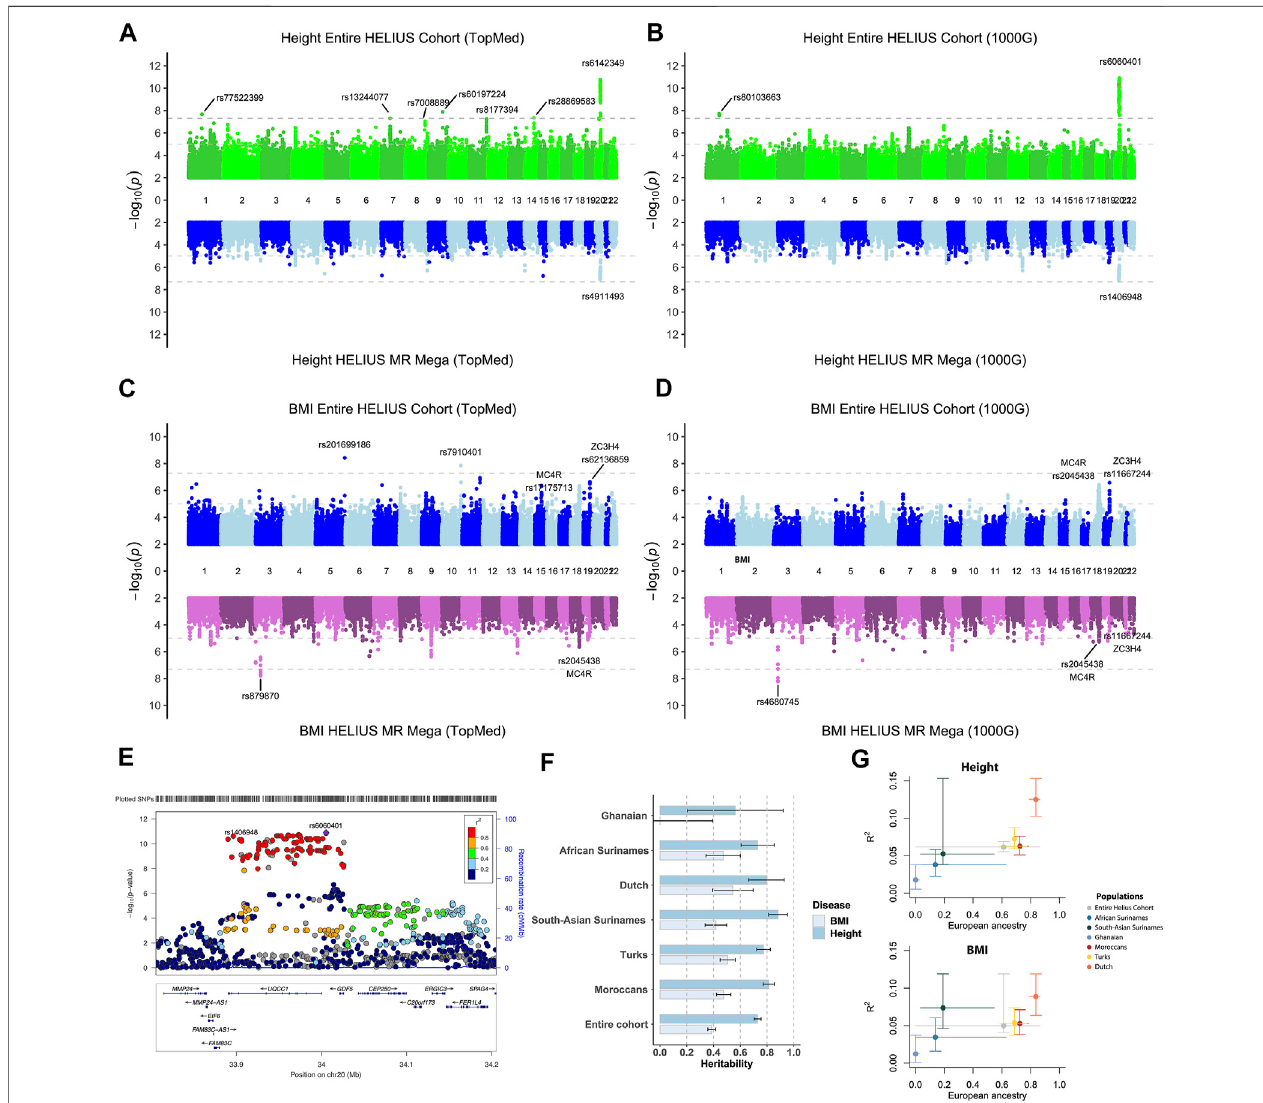
FIGURE 3 | Height and BMI association study on the HELIUS cohort. Miami plot of the height and BMI using the TopMed (A, C) or Sanger 1000G imputation referencecohort (B,D) GWAS.Resultsoftheentirecohortareplottedatthetoppanels,andtheMR-MEGAmeta-analysiscombinestheethnic-speci fi cGWASresultsat the bottom panel. Y -axis displays the -log10 p values and the x -axis the associated marker location on each chromosome. Gray dashed lines indicate the 1.0e-5 and genome-widesigni fi cant5.0e-8 p -valuethresholds. (E) Locuszoomoftheheightassociationpeakonchromosome20showingtheassociatedlociUQCC1/GDF5 within the area. (F) Heritability, and standard error, bar plot for the entire or ethnic-speci fi c cohort, and each ethnic-speci fi c GWAS for the BMI and height. The PRS for BMIandheightisdisplayedin (G) .The y -axisrepresentsthe “ best fi tted ” R2fortheentirecohortandeachethnicitywithverticalerrorbarsrepresentingthebootstrapping con fi denceinterval.TheaverageproportionofEuropean ancestry,basedontheADMIXTUREK (cid:1) 3calculations,fortheentirecohortandperethnicityisdisplayedatthe x -axis. Horizontal lines were drawn between the smallest and largest measured European ancestry values for that group.